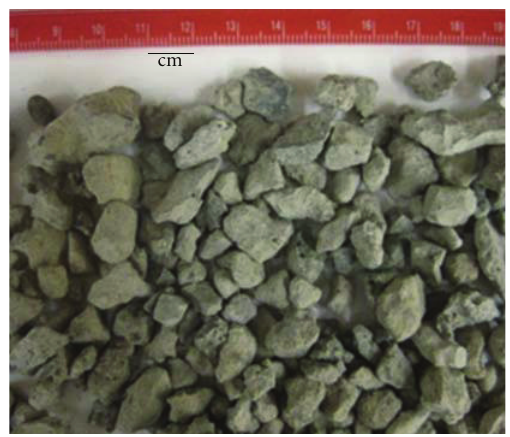
Figure 6: Gravel-size BOF slag